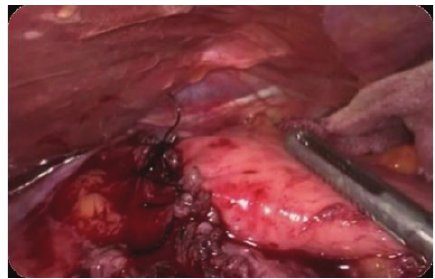
Figure 4: Dor fundoplication.